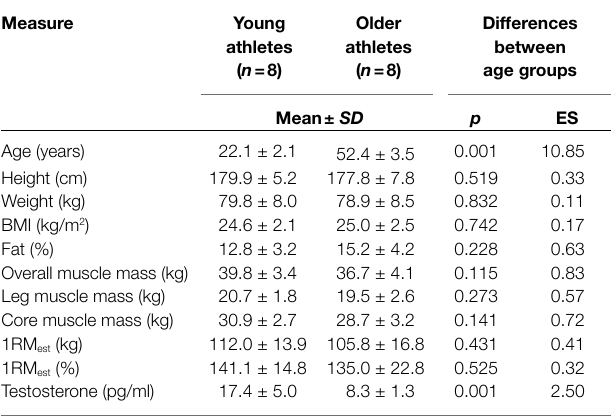
TABLE 1 | Baseline physical characteristics of the participants. Measure Young